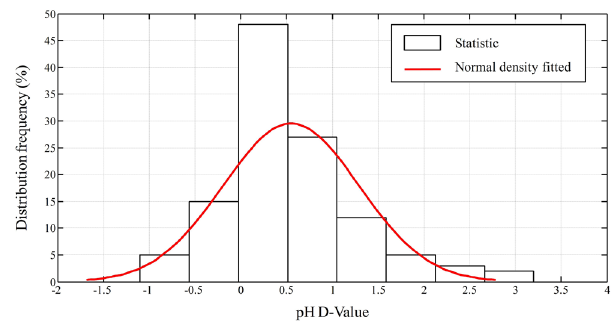
Fig 3. Frequency distribution of pH difference-values (D-Value) between termite mounds and surrounding